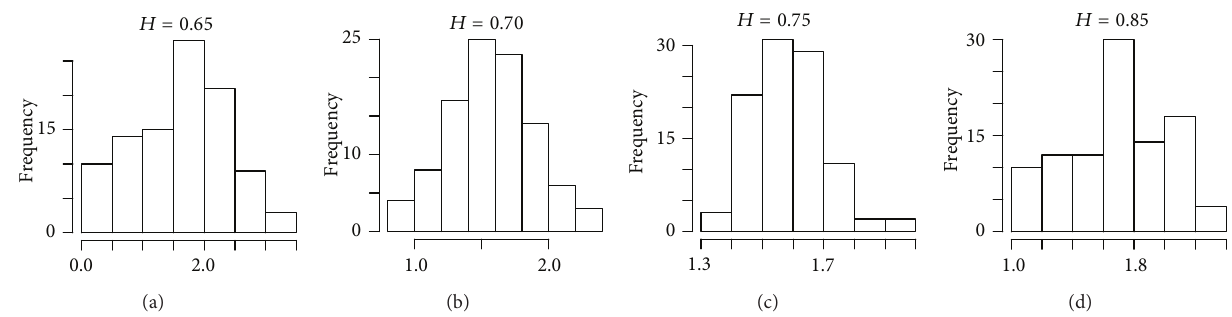
Figure 2: Histogram of the estimator ̂𝛼 ( 𝛼 = 1.5880 ) for different values of 𝐻